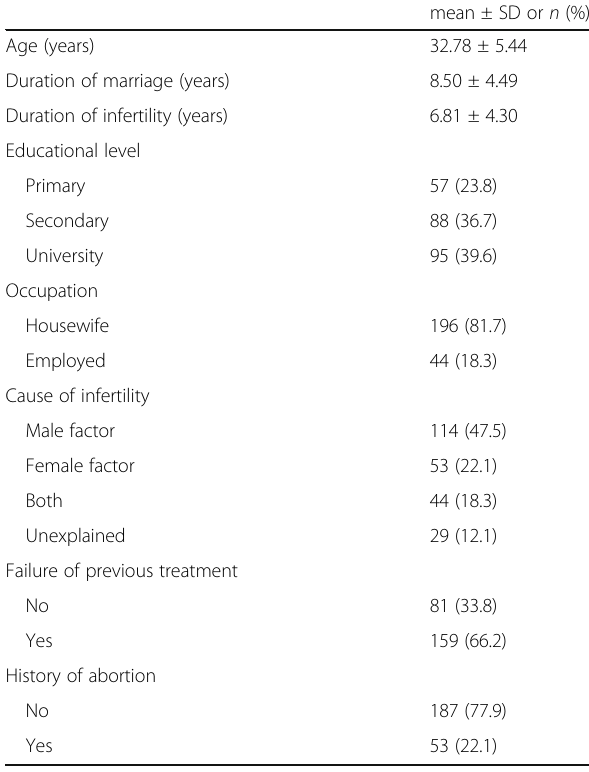
Table 1 Demographic and clinical characteristics of